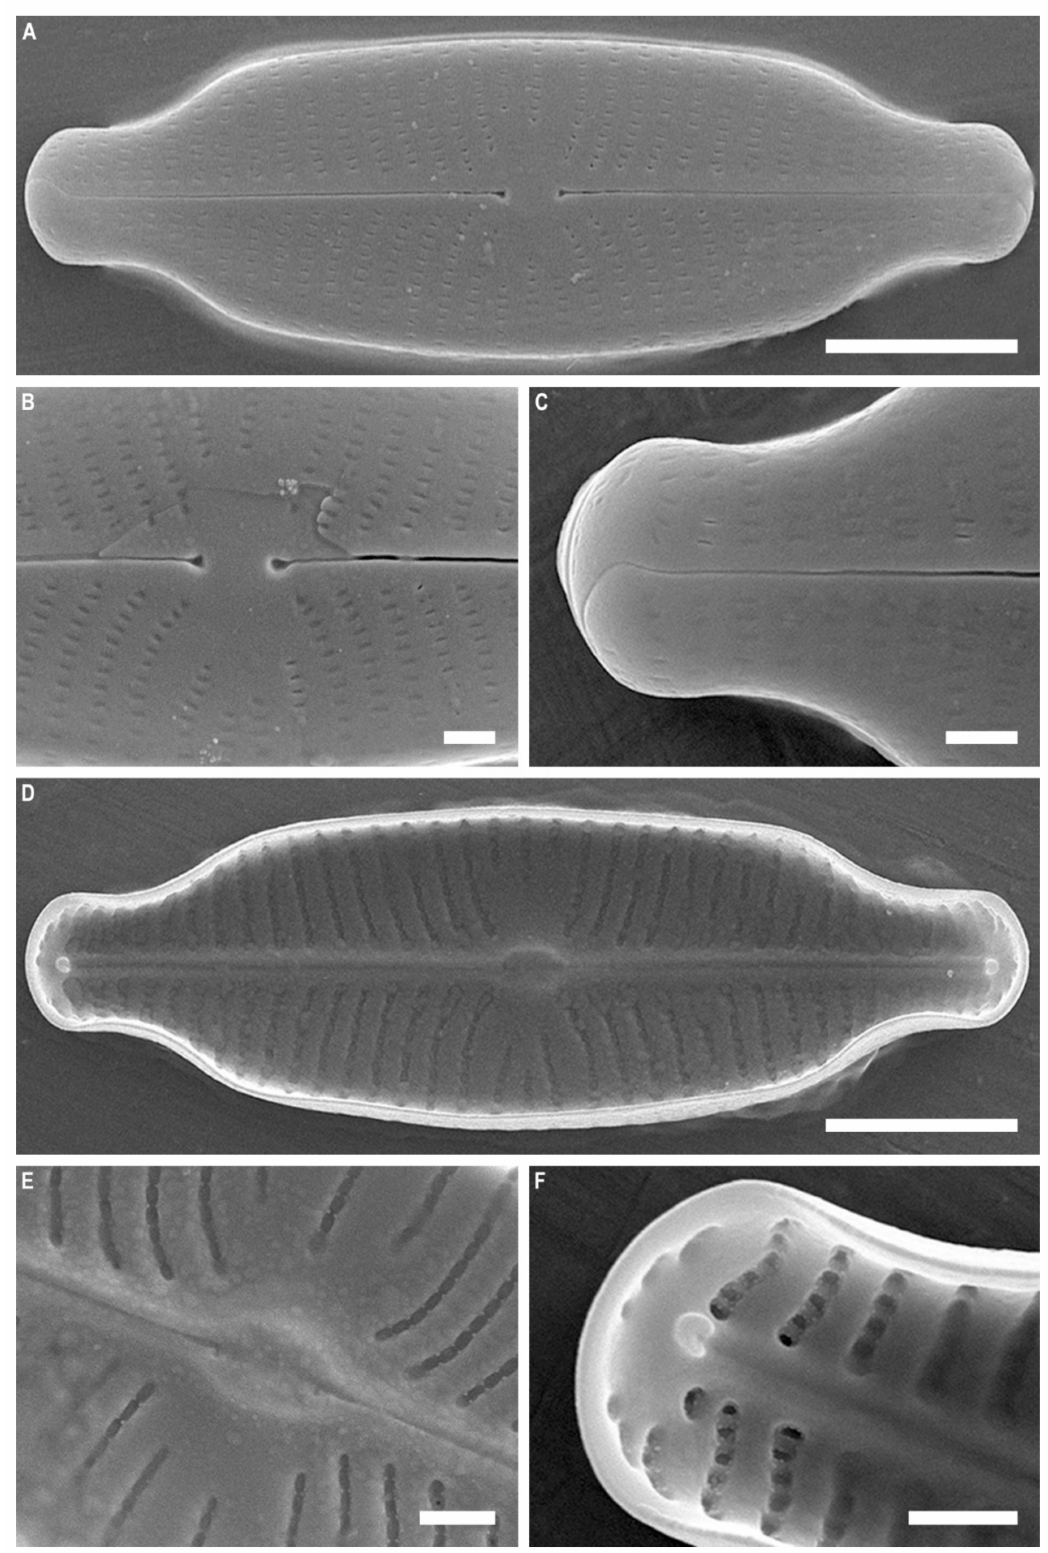
Figure 7. Placoneis subundulata Kezlya, Kulikovskiy & Kociolek sp. nov. Strain VN1199, sample no. 01682. Scanning electron microscopy: ( A – C ). External views. ( D – F ). Internal views. ( A , D ) The whole valve. ( B , E ) Central area details. ( C , F ) Valves ends. Scale bars ( A , D ) = 5 µ m; ( B , C , E , F ) = 1 µ